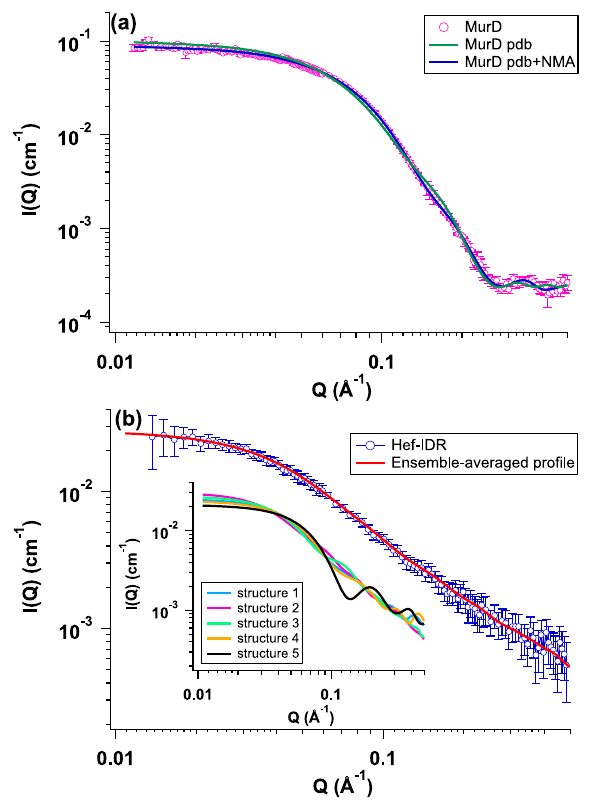
Figure 1. SAXS profiles of MurD and Hef-IDR. (a) Pink circles indicate experimental SAXS profile of MurD. Green and blue lines correspond to SAXS profiles calculated with its crystal (PDB code: 1e0d.pdb) and deformed structures by normal mode analysis (NMA), respectively. (b) Blue circles, experimental SAXS profile of Hef-IDR. Red line, ensemble-averaged profile of five representative structures. Inset, SAXS profiles of representative structures 1 (light blue), 2 (pink), 3 (light green), 4 (yellow) and 5 (black). This figure is prepared by the usage of IGOR Pro 6.34A (https ://www.wavem etric s.com/forum /news-and-annou nceme nts/igor-634a- now-shipp